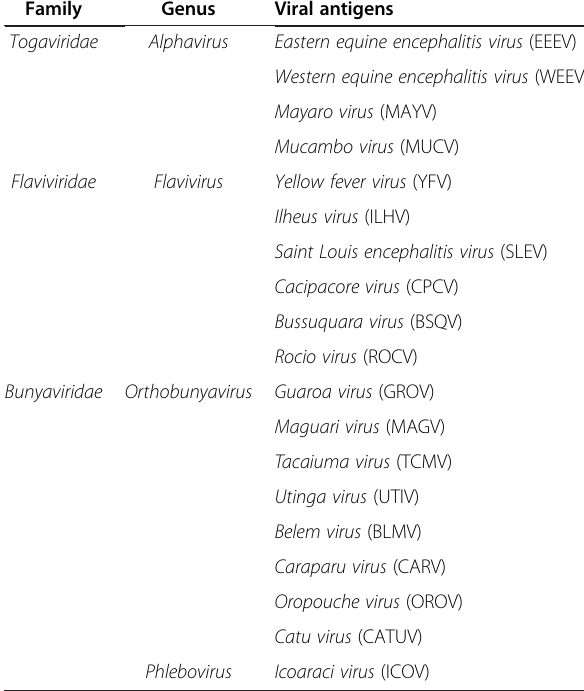
Table 1 Arbovirus antigens comprising 19 arbovirus types isolated in Brazil and belonging to the collection of the arbovirology and hemorrhagic fevers section of